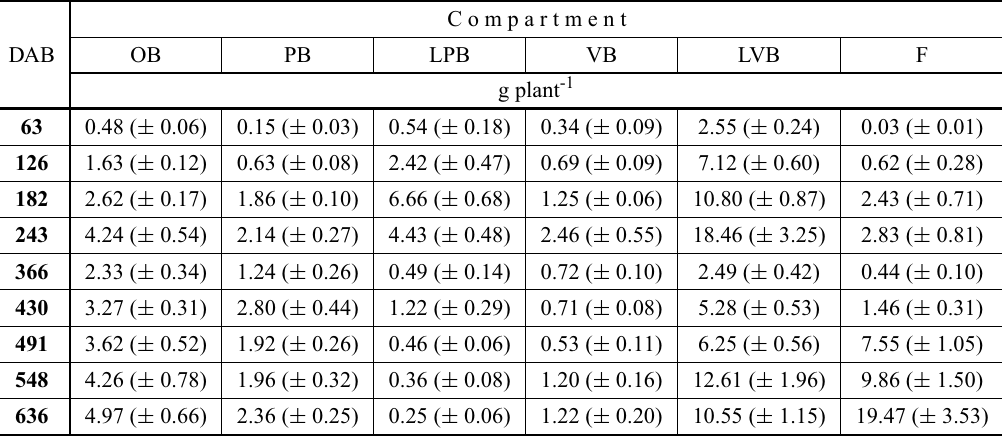
Quantities of N derived from the fertilizer and accumulated in each compartment of the coffee plant (QNdff) as a function of time (DAB = days after beginning, starting Sept 1, 2003).